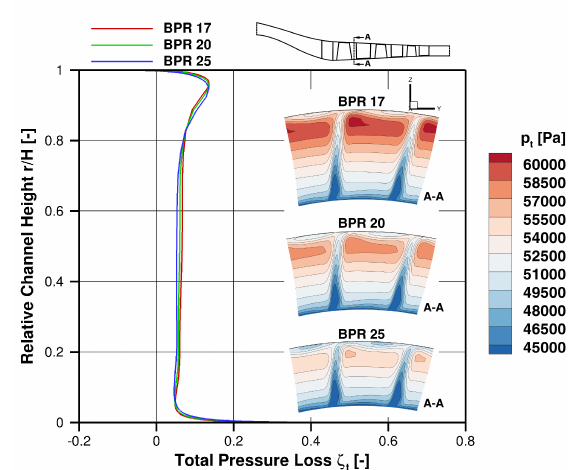
Figure 9. Effect of bypass variations on rotor 1 at design point (DP).